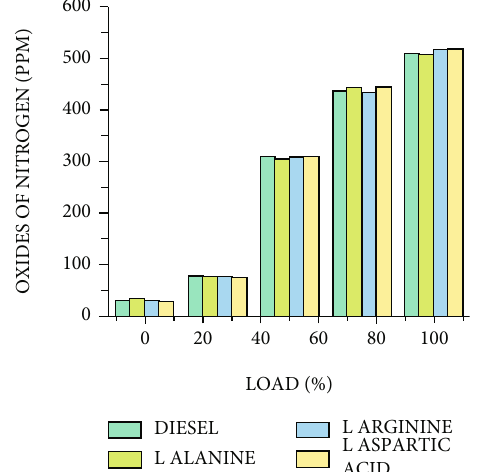
Figure 14: Variation of NO load.